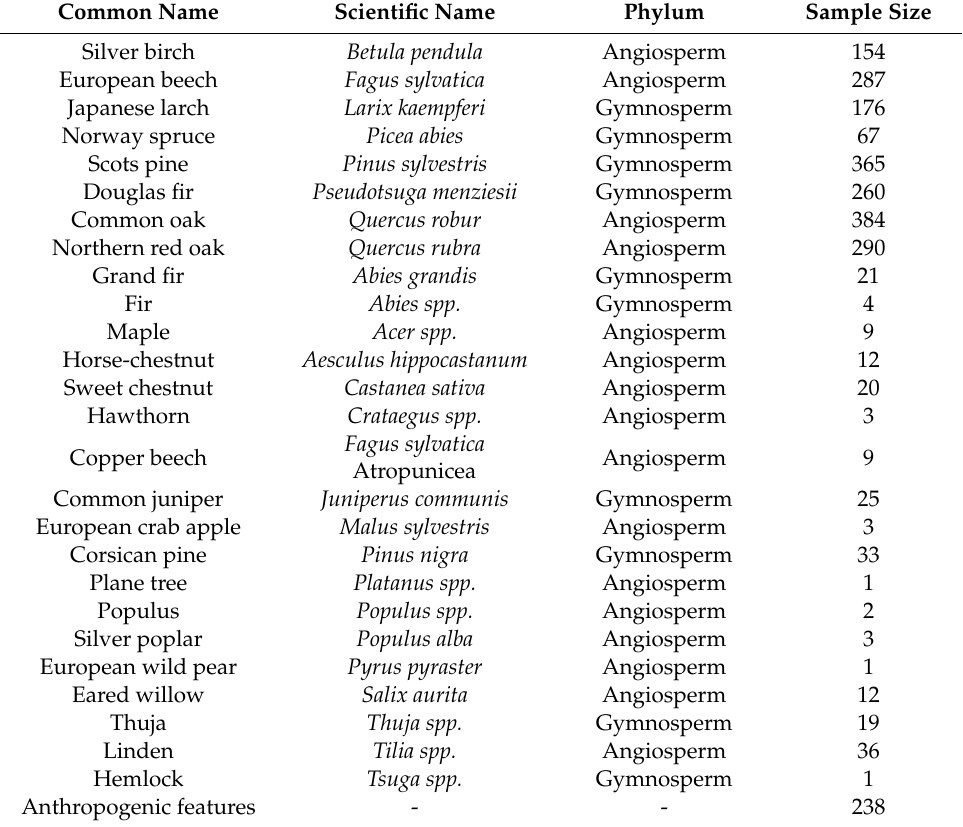
Table 1. Inventory data of trees and anthropogenic features (n =